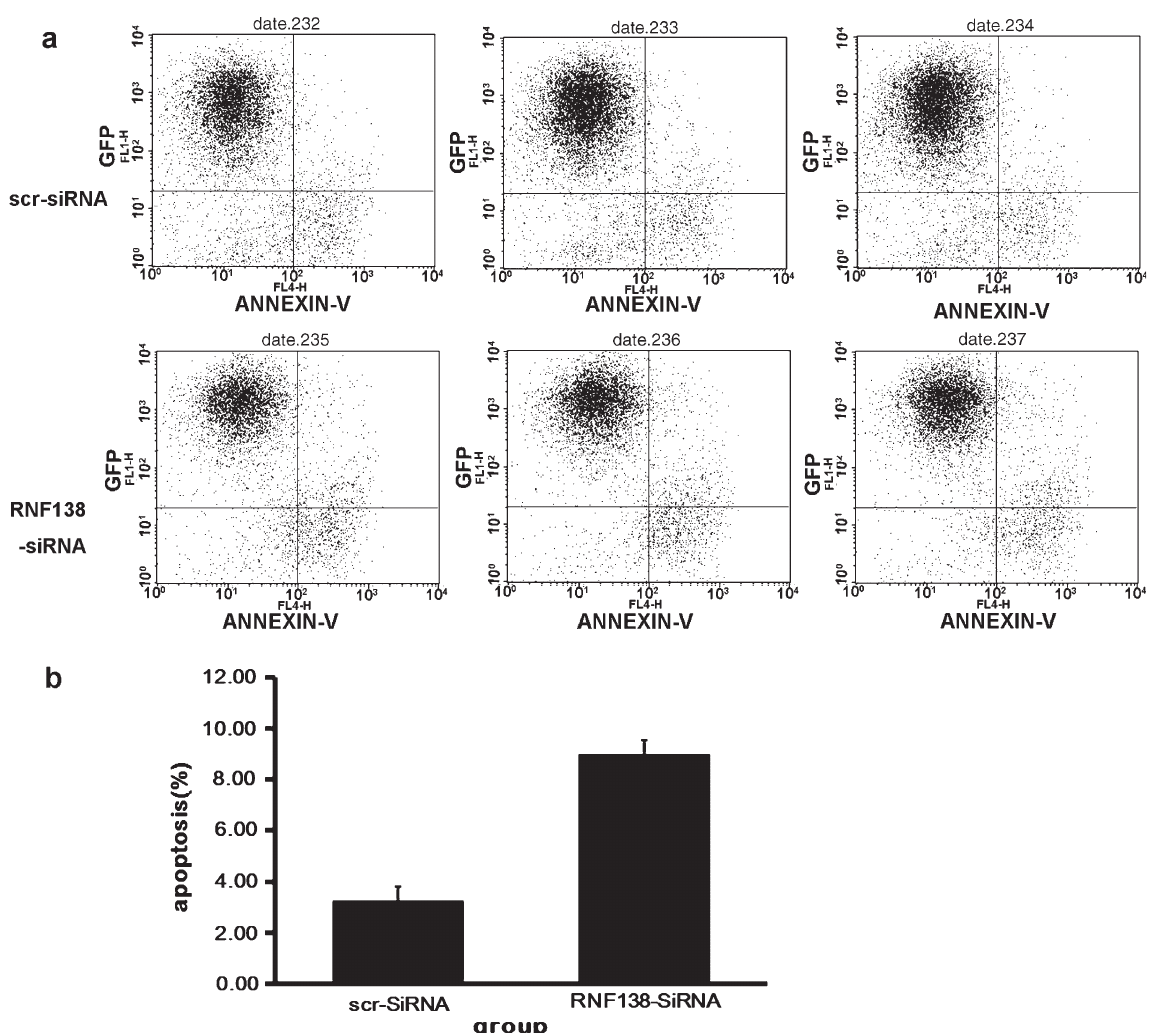
Fig. 7. Effect of down-regulation of RNF138 on cell apoptosis of U251 cell. It was detected after five-day transfected. (a) scatterplot chart of cell apoptosis by FACS. (b) bar charts of cell apoptosis rate was drawn according to result of the FACS. The apoptosis rate in this group of NC and KD is (3.26 ± 0.54)%, (9.0 ± 0.55)% respectively ( p =0.0003). (c) Apoptosis peak was detected by FACS. (d) bar charts of cell apoptosis rate was drawn. The apoptosis rate in this group of NC and KD is (9.23 ± 1.82)%, (17.16 ± 0.43)% respectively ( p =0.01). The results indicated that down-regulation of RNF138 increased the cell apoptosis of U251